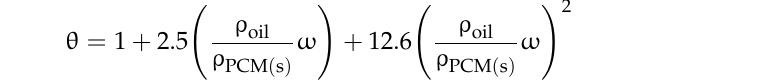
Figure 2. Recovered heat using pure silicone oil in simulations and experiments.